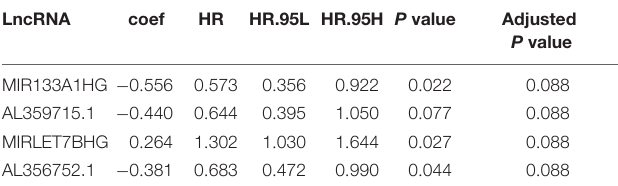
TABLE 2 | Information for four lncRNAs from multivariate Cox